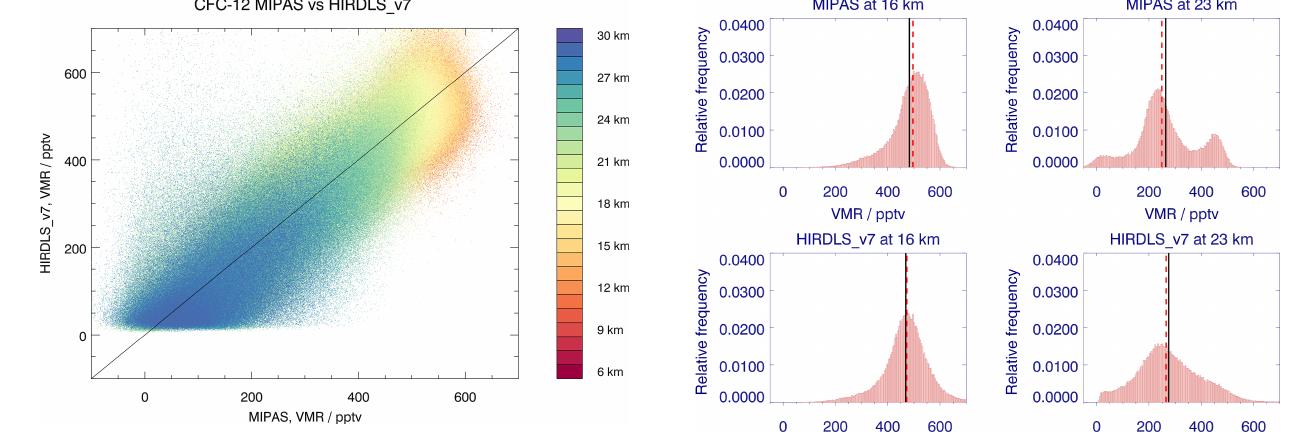
Figure 20. Correlation of collocated MIPAS CFC-12 measurements with HIRDLS measurements during the time period of 2005 to 2008.